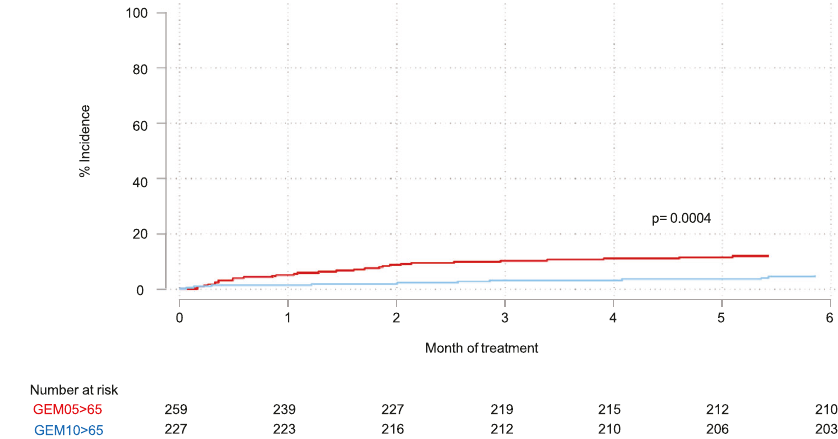
Fig. 2 Cumulative incidence of severe infections comparing non-candidate transplant patients.